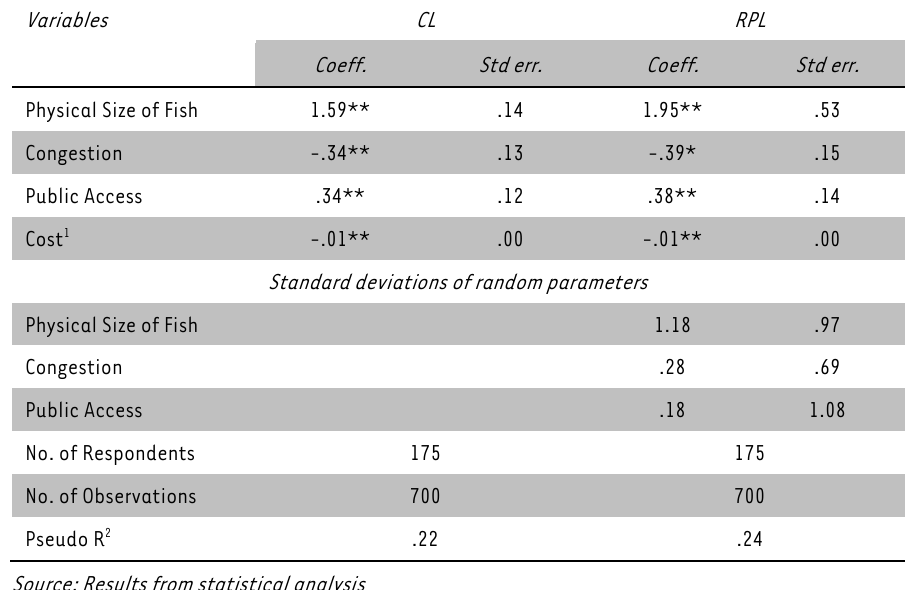
TABLE 5: Estimation results of the